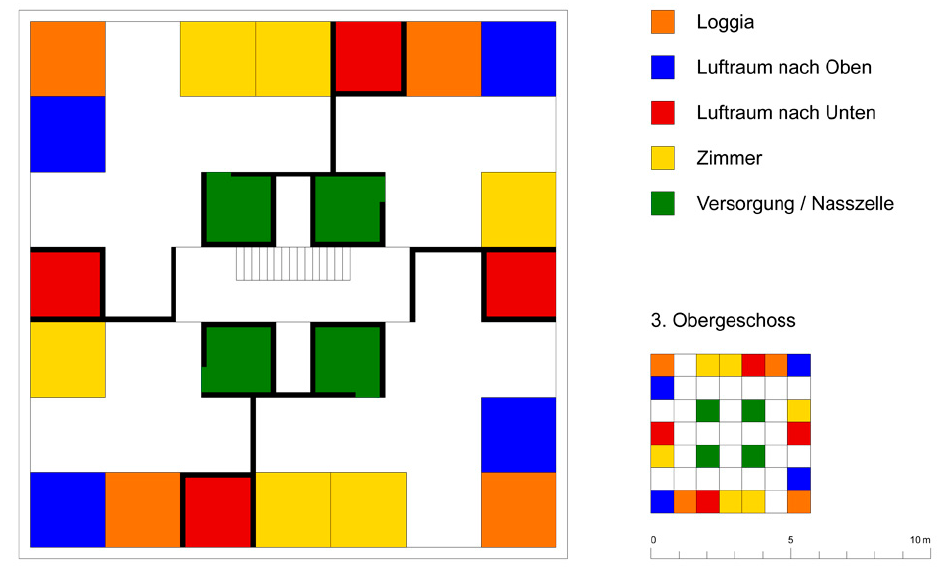
Figure 5. Residential building St. Gallenkirch, 3rd floor. EU Mies Award Archive. https://eumiesaward.com/work/3523 (accessed on 8 February 2021).